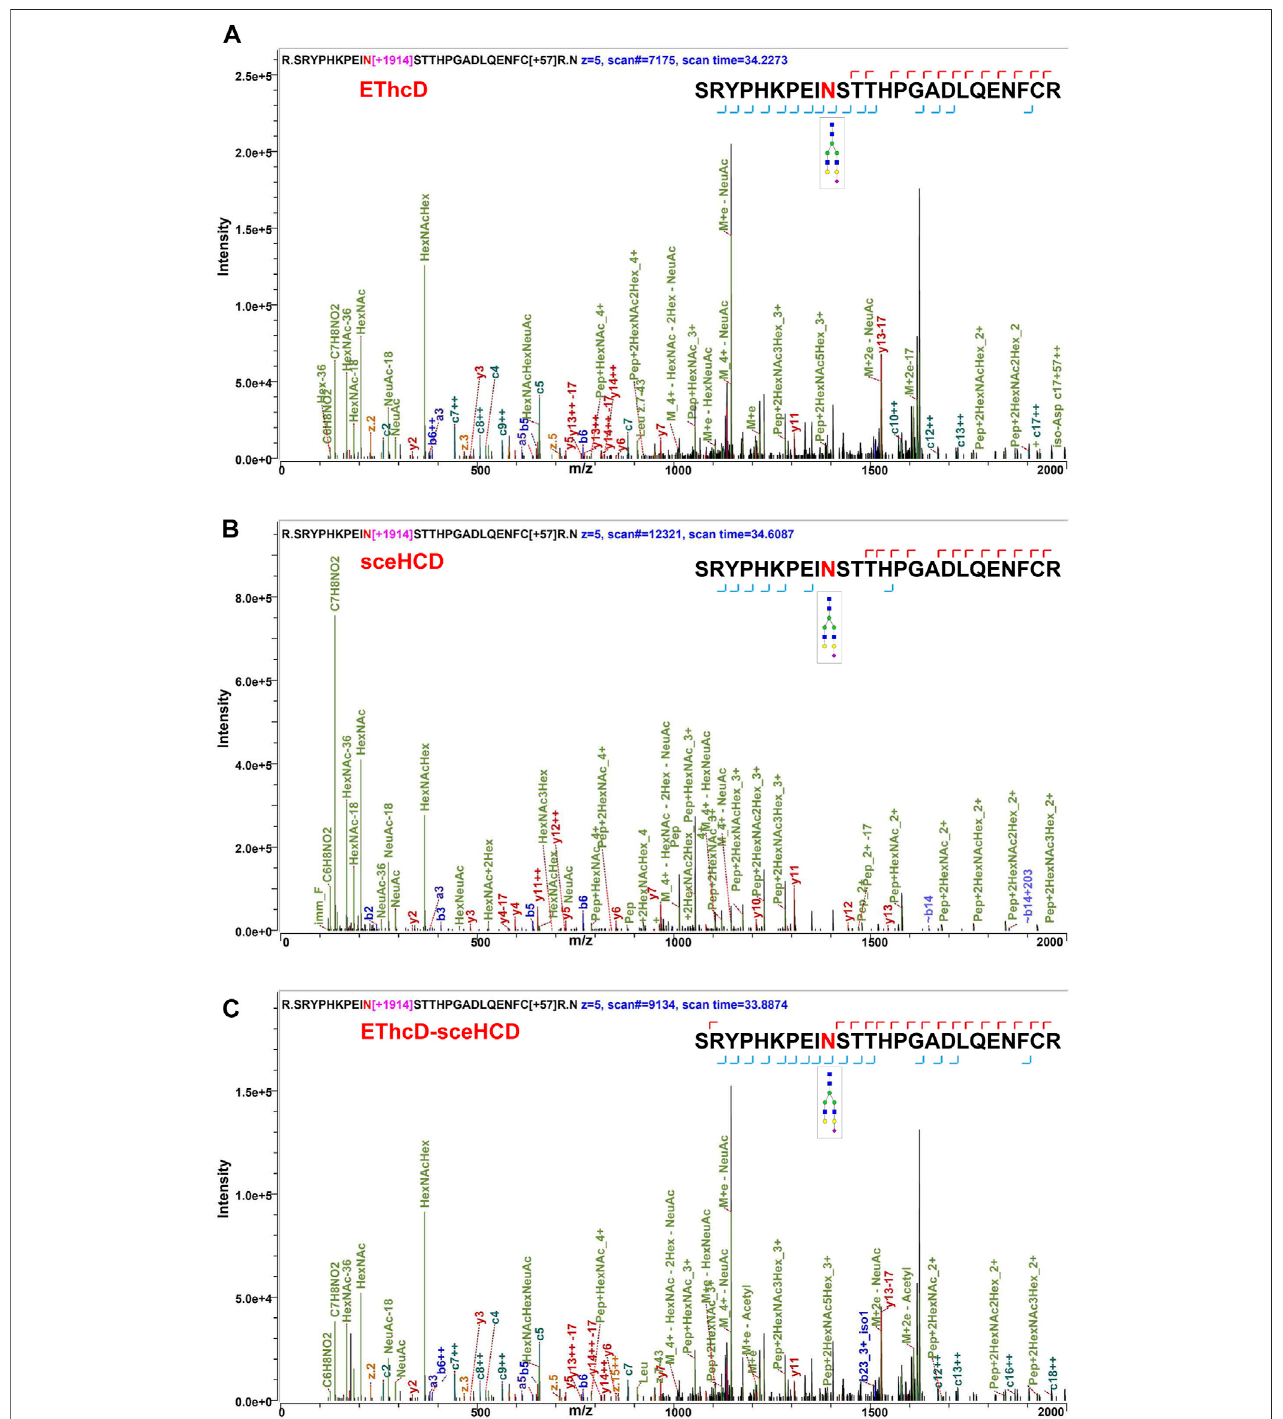
FIGURE 3 | Comparison of the EThcD (A) , secHCD (B) , and EThcD-sceHCD (C) spectra of prothrombin intact N-glycopeptides (N143) from human plasma.